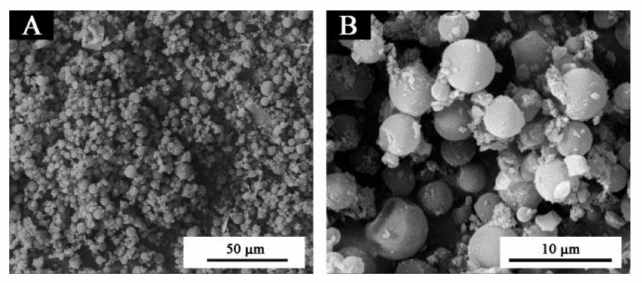
Figure 2. SEM of thermochromic microcapsules: ( A ) low and ( B ) high